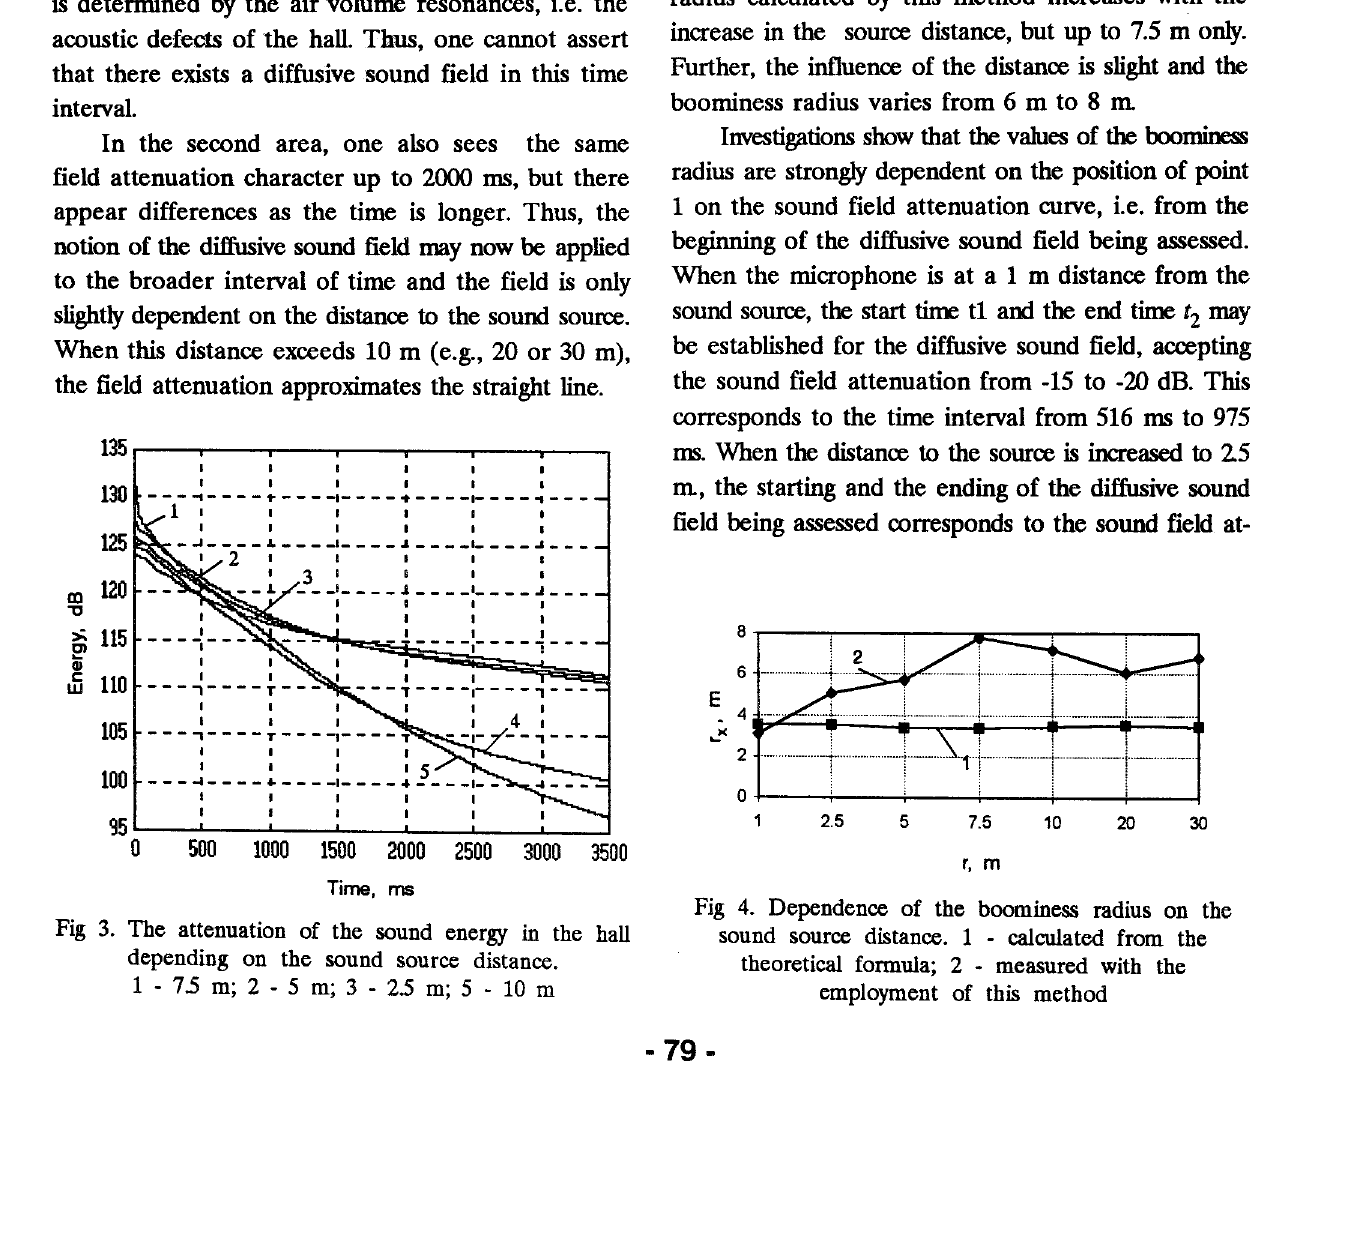
Fig 4. Dependence of the boominess radius on the sound source distance. 1 - calculated from the theoretical formula; 2 - measured with the employment of this method •